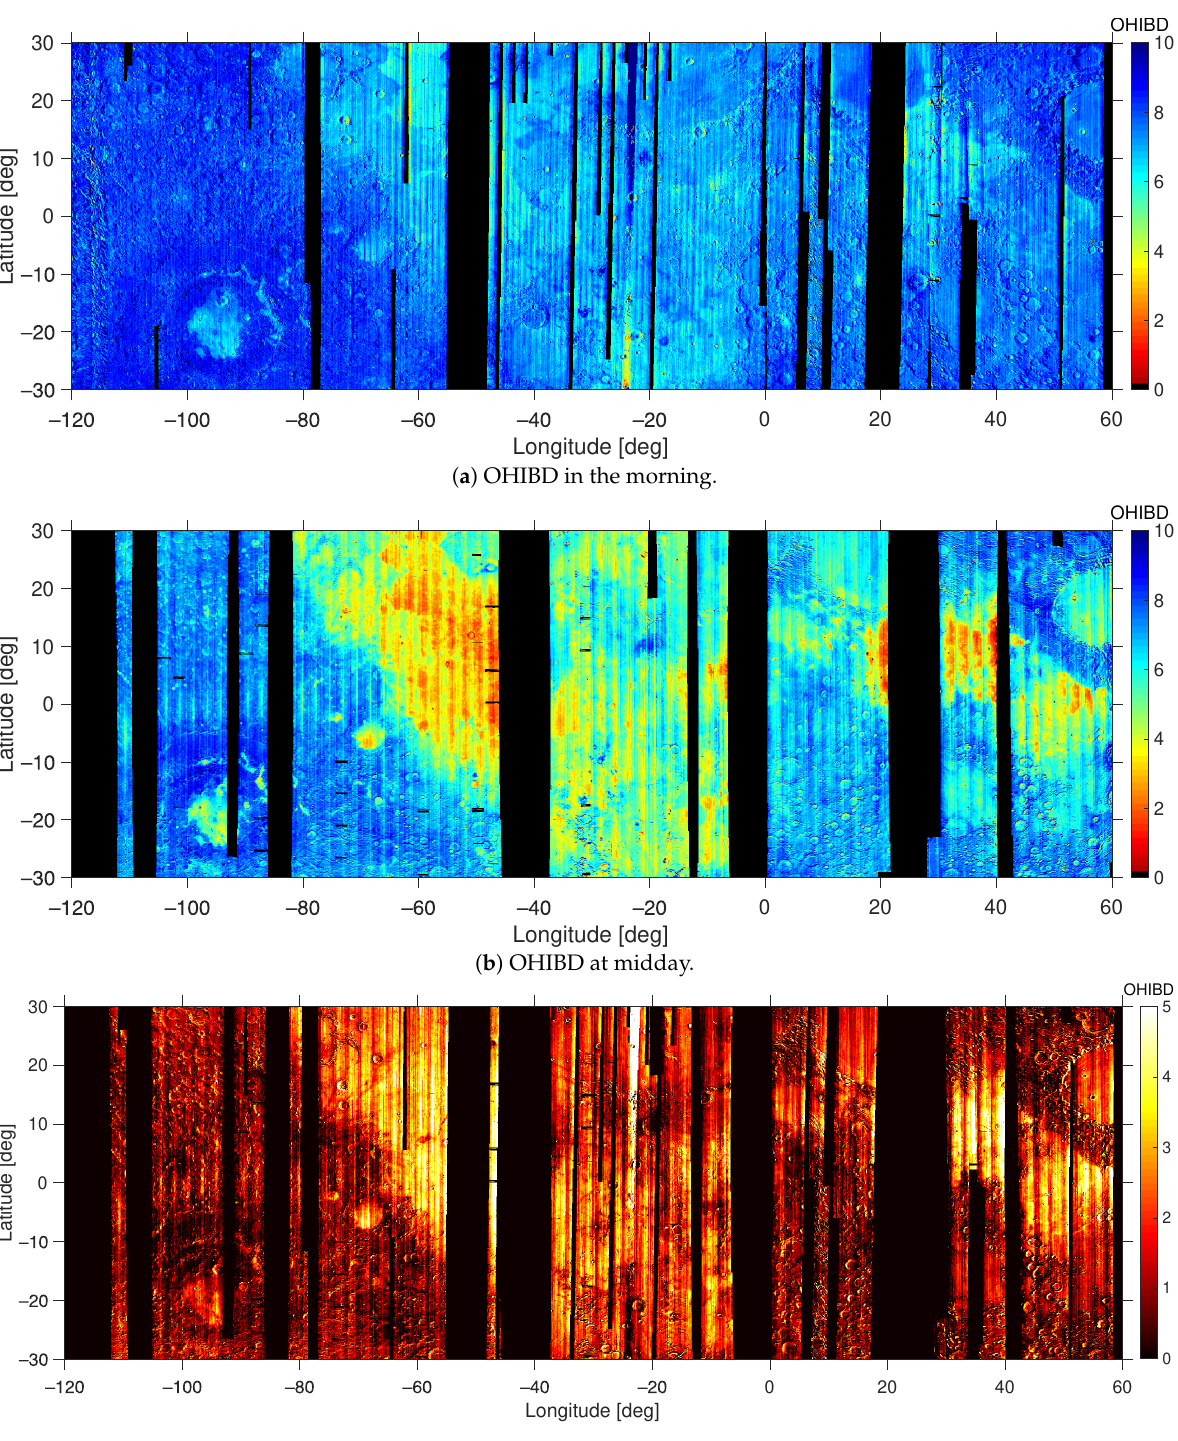
( c ) OHIBD morning–midday difference. Figure 3. ( a ) Map of OHIBD values determined from the morning M 3 data. ( b ) Map of OHIBD values determined from the midday M 3 data. ( c ) Map of OHIBD difference between morning and